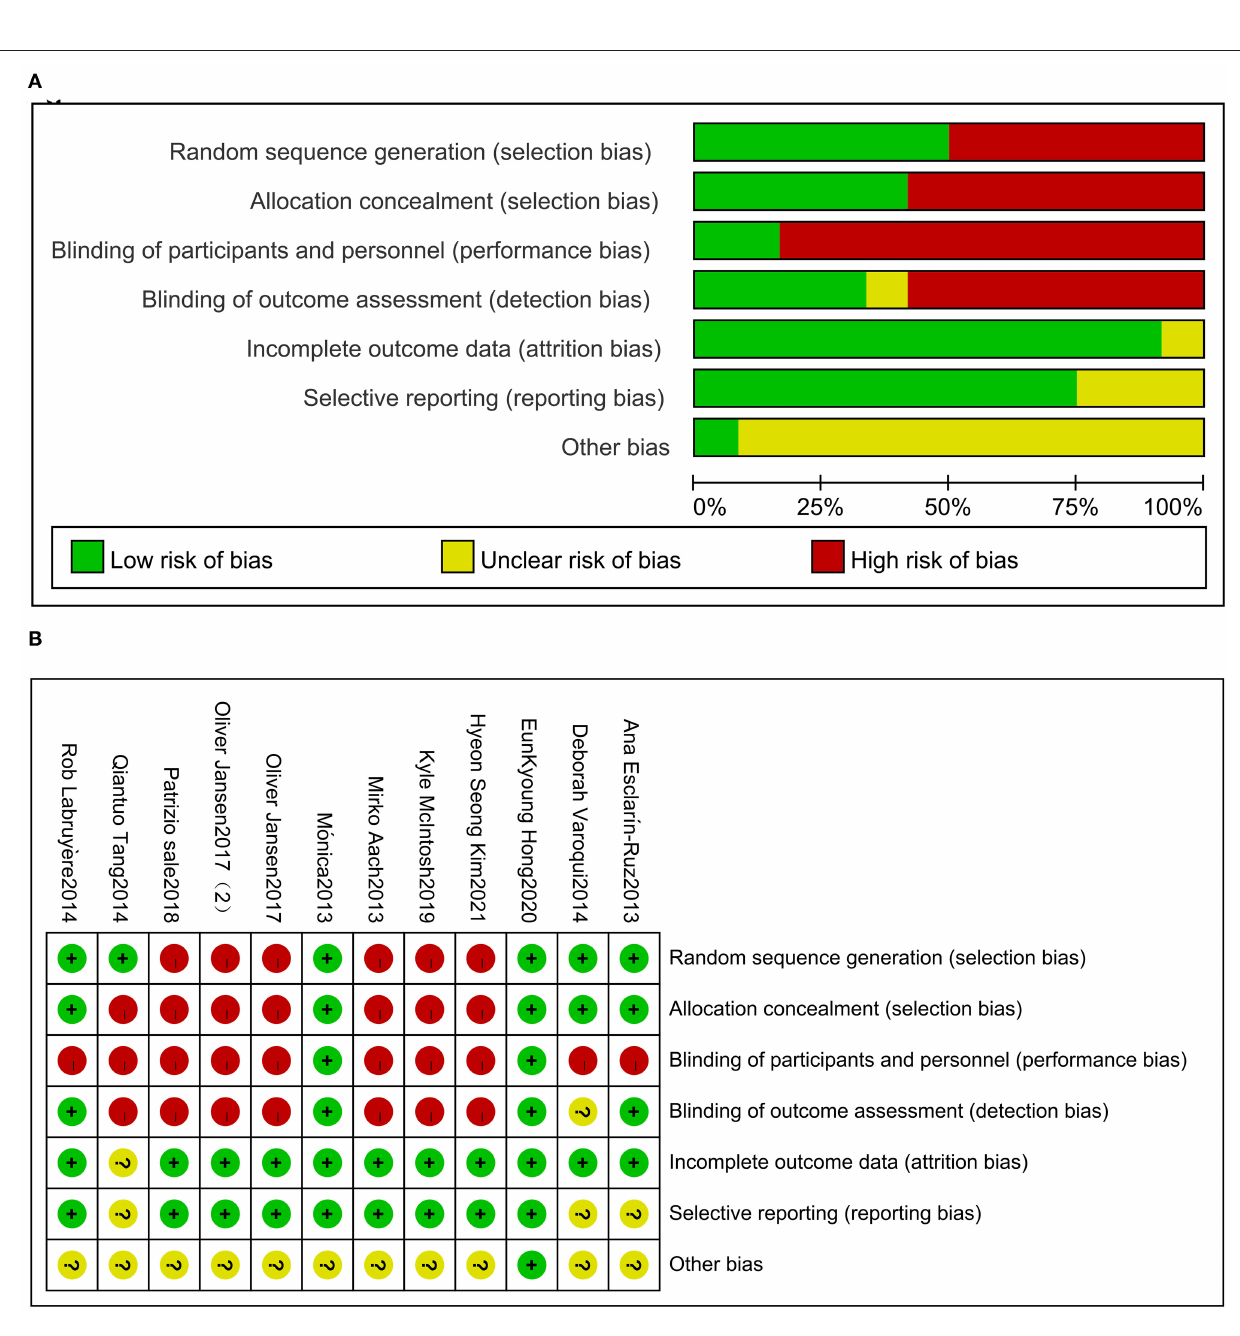
outcomes of patients undergoing wearable EAW and Lokomat training ( P > 0.05; Supplementary Materials